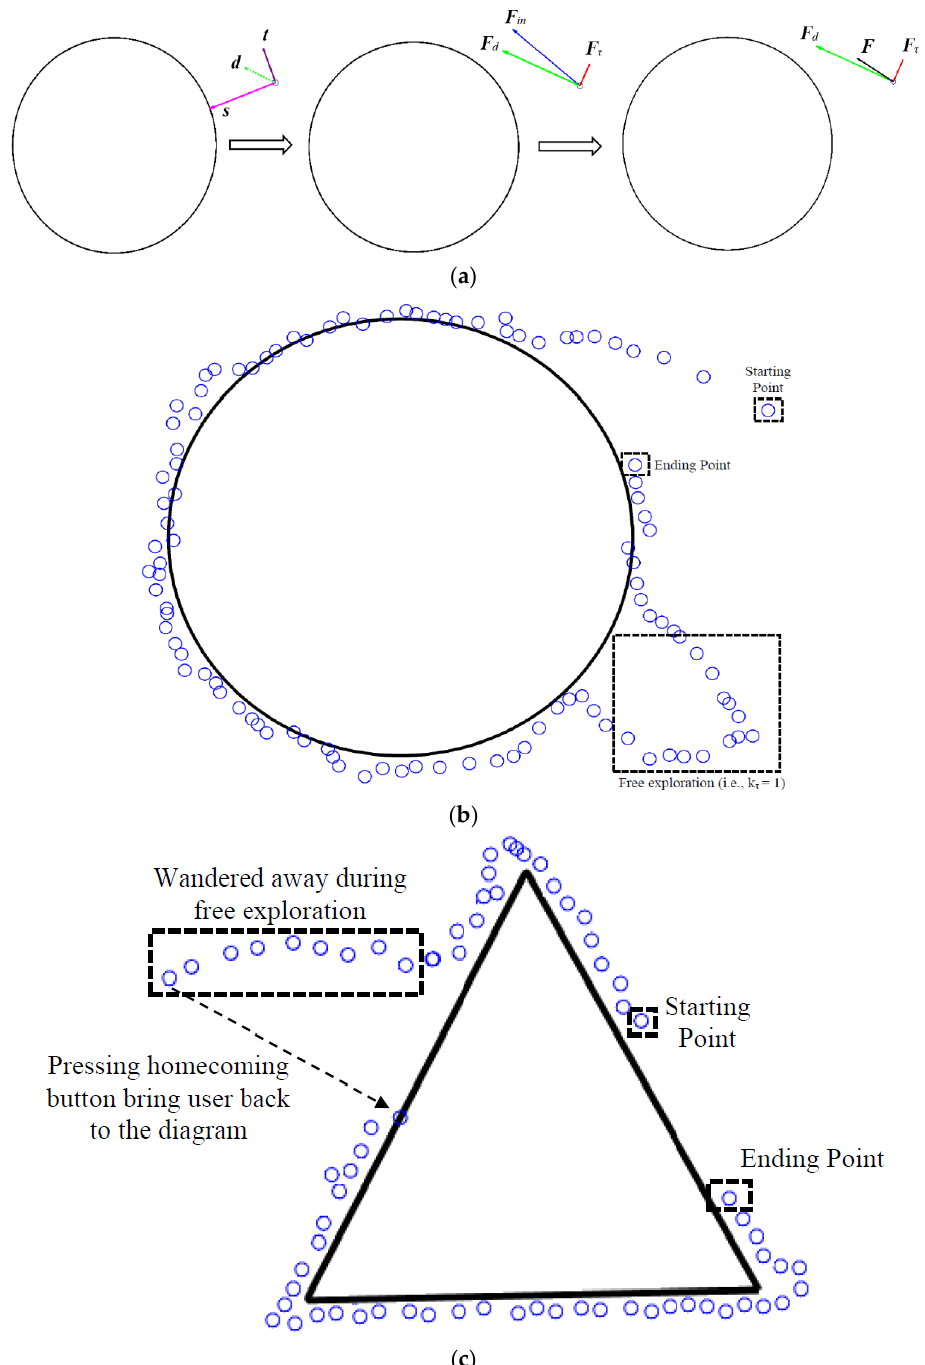
Figure 6. ( a ): Shows an illustration of a sample virtual diagram (circle) and the calculation of the final force depending on the location of the mobile robot and applied force. Here, both the admittance value ( k τ ) and stiffness factor ( k s ) are set to 0.5. ( b ): Shows an illustration of a virtual object (circle) and the path followed by the mobile robot in response to a user’s input force. Here, the stiffness factor ( k s ) is set to a value of 0.5. The admittance value ( k τ ) is set to 0.25 for all locations (i.e., to promote movement along the desired direction) except for locations marked with the dotted square (free exploration, k τ = 1). ( c ): Shows an illustration of an equilateral triangle and the path followed by the mobile robot in response to a user’s input force. Use of homecoming button brings user back to the nearest point on the diagram. Blue circles show position of the robot w.r.t to the